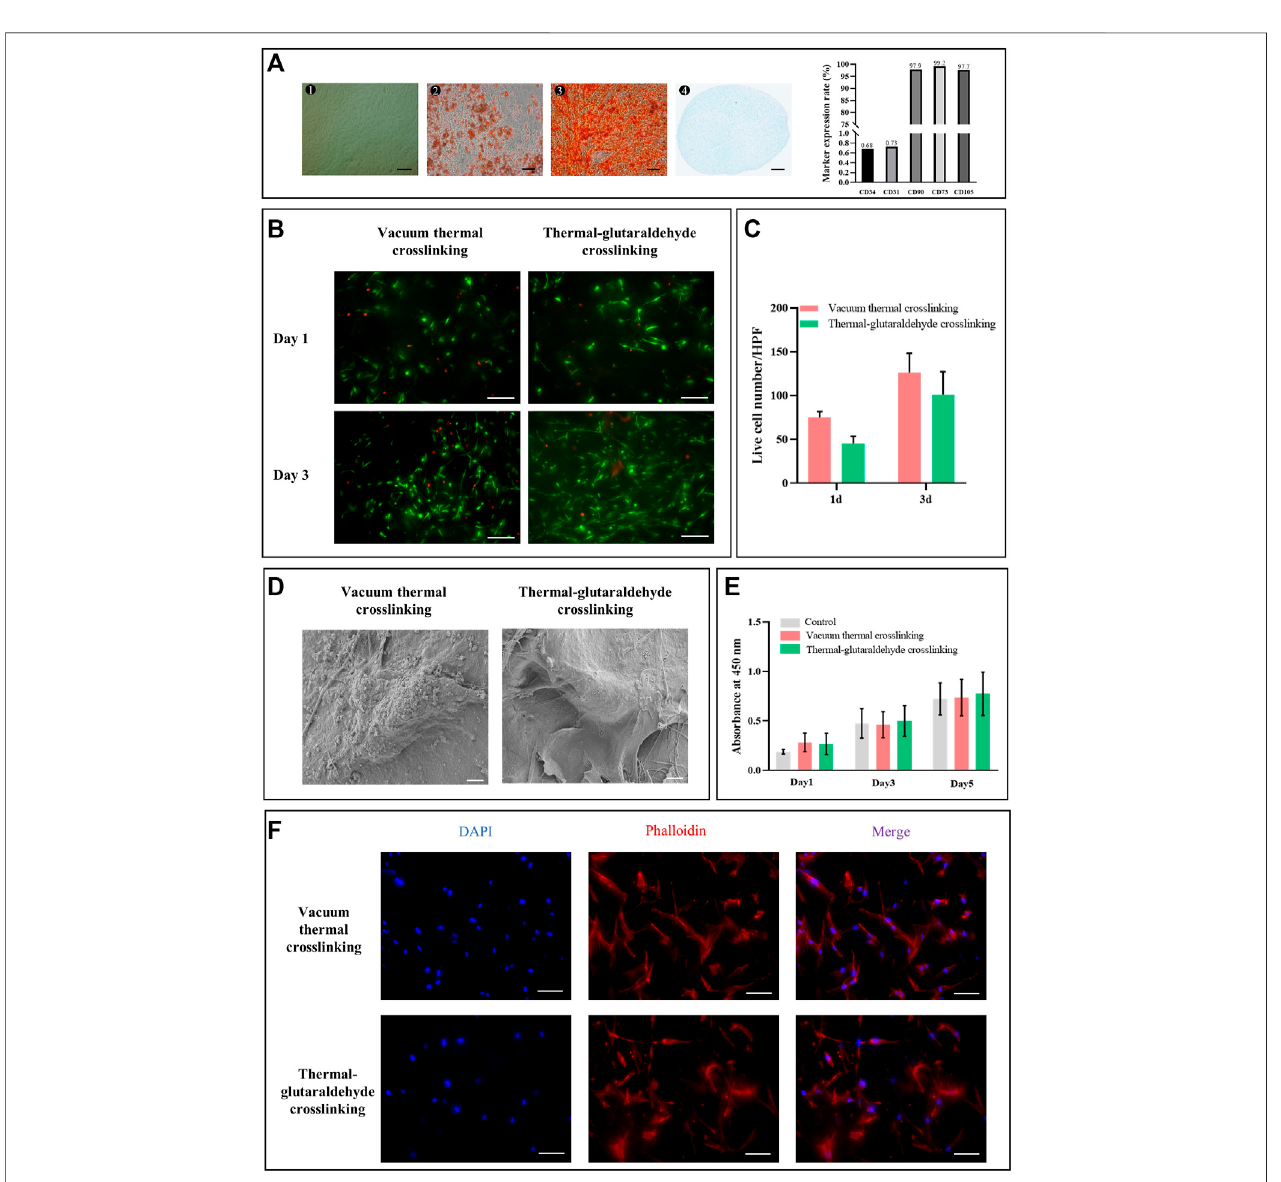
FIGURE3| Biocompatibilityofthecrosslinked sponges. (A) Morphology(bar=200 μ m) anddifferentiationpotential(bar=100 μ m) ofhADSCs. Markerexpression rate wasanalyzedby fl ow cytometry. (B) Live and dead staining ofhADSCs on theADM spongescrosslinked bythe vacuum thermal method or thermal-glutaraldehyde method, bar = 100 μ m. (C) Calculation of live cells per high power fi eld on the crosslinked ADM sponges on days 1 and 3. (n = 3 for each group). (D) SEM images of hADSCs on the surface of ADM sponges, bar = 5 μ m. (E) hADSC proliferation on days 1, 3 and 5 cultured in the extracts from VT-ADM, GA-ADM, and complete DMEM, respectively ( n = 3 for each group). (F) hADSC adhesion to AT-ADM and GA-AMD stained by phalloidin, bar = 100 μ m (blue for nucleus; red for cytoskeleton). *p < 0.05 , **p < 0.01 , ***p < 0.001 , and ****p < 0.0001.